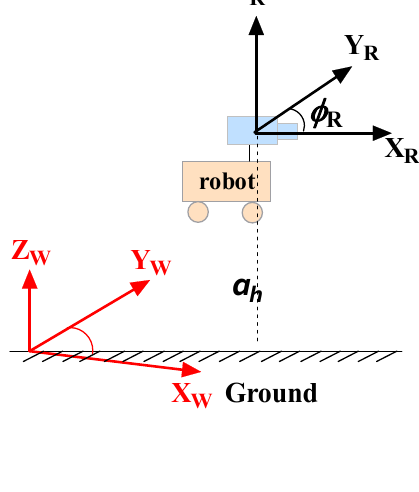
Figure 1. The world and robot/camera coordinate reference. Red and subscript W: world reference; black and subscript R: camera/robot reference. a ground